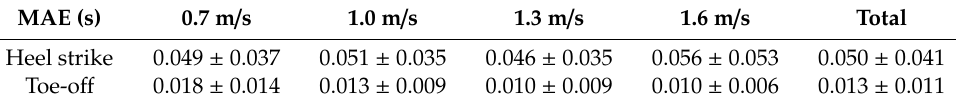
Table 1. Mean absolute error (MAE) of the estimated gait events for all participants.